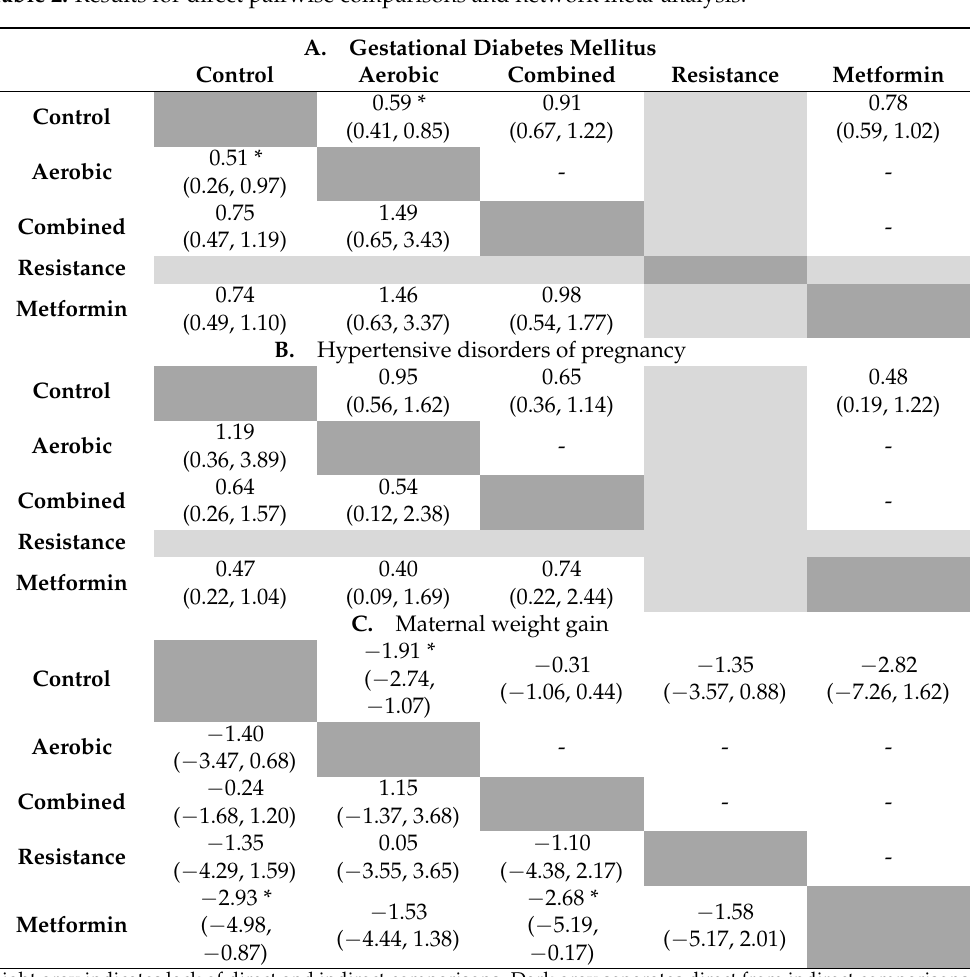
Table 2. Results for direct pairwise comparisons and network